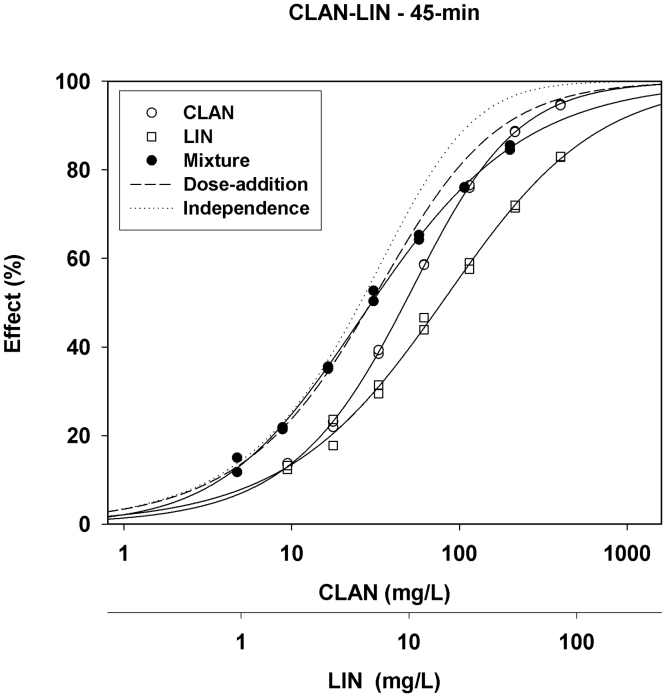
Concentration-effect curves for chloroacetonitrile (CLAN), linalool (LIN) and the CLAN-LIN mixture after 45-min of exposure, along with predicted curves for dose-addition and independence. Mixture toxicity was consistent with the combined effects models at lower effect levels but was right-shifted from those models above about 60% effect.